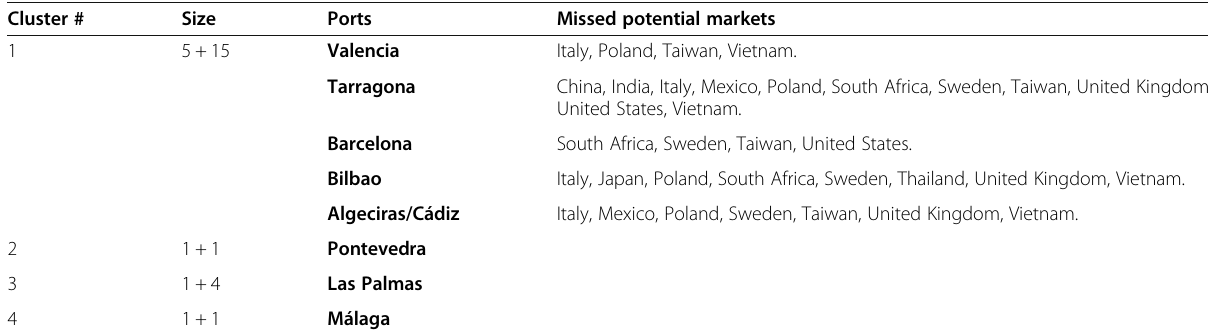
Table 6 Communities and link prediction for the “ Automobiles and their parts ” import graph, in 2019. Size means number of ports + number of countries in the community